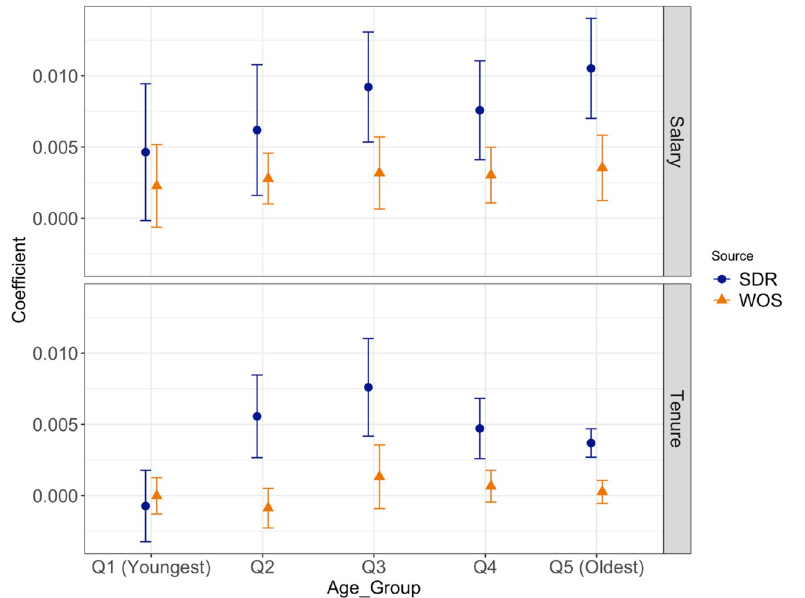
Fig 4. Relationship between outcomes and SDR and WoS publication counts by quintiles of academic age. Notes: This figure plots the coefficients and 95% confidence intervals of the coefficients from regressions of ln(Salary) (upper panel) and an indicator for tenure status (lower panel) on publication counts from the SDR and WoS using 2003 SDR data. Each panel reports estimates from 5 separate regressions stratified by academic age. From the left to right, the bins are [1,4], [5,9], [10,16], [17,25], [26,45]. regression estimates for each outcome variable: ln(salary) (upper panel) and tenure status (lower panel). We find that when the match probability is low (quintiles 1 or 2), WoS publica- tion counts have significantly lower explanatory power than SDR publication counts. As the match quality gets higher, the coefficient on WoS publication counts increases and even exceeds the coefficient on SDR publication counts in some subgroups. This pattern is robust in the 2008 and 1995 datasets (see sub-figure A in Figs A9 and A10 in S1 Appendix). A similar pattern emerges in Fig 5, sub-figure B, where the coefficient on the WoS publica- tion counts is higher for people with more WoS publications that were matched in earlier rounds. Specifically, the coefficient on the WoS publication counts is not statistically different from the coefficient on SDR publication counts when the best matches could be made. The same pattern also shows in the results using the 2008 and 1995 data (sub-figure B in Figs A9 and A10 in S1 Appendix): the coefficient on the WoS publication counts is not statistically dif- ferent from, or is even larger than, the coefficient on SDR publication counts when the best match or the second-best matches could be made. This finding reaffirms that the WoS publica- tion count has larger explanatory power than that of SDR when WoS publications are matched with high quality.